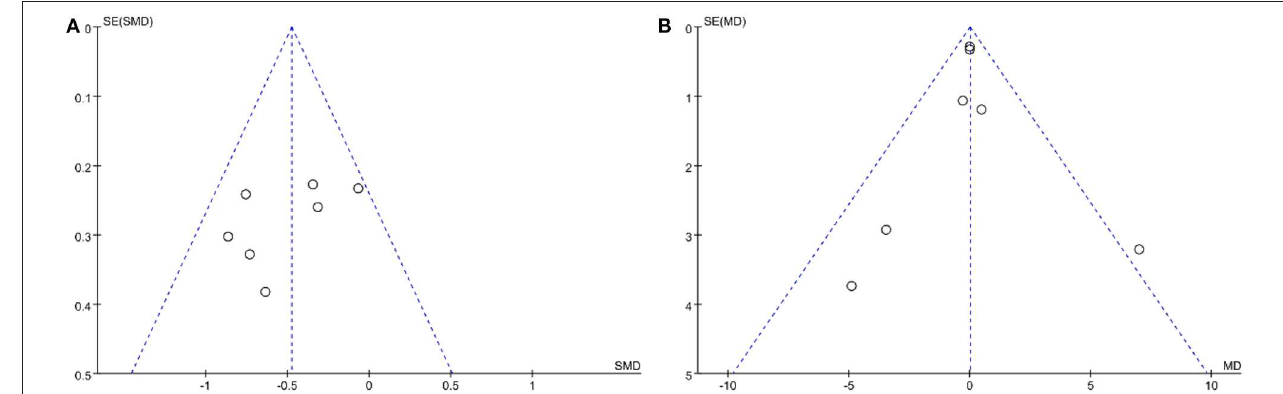
FIGURE 5 | (A) Funnel plot of depression. (B) Funnel plot of